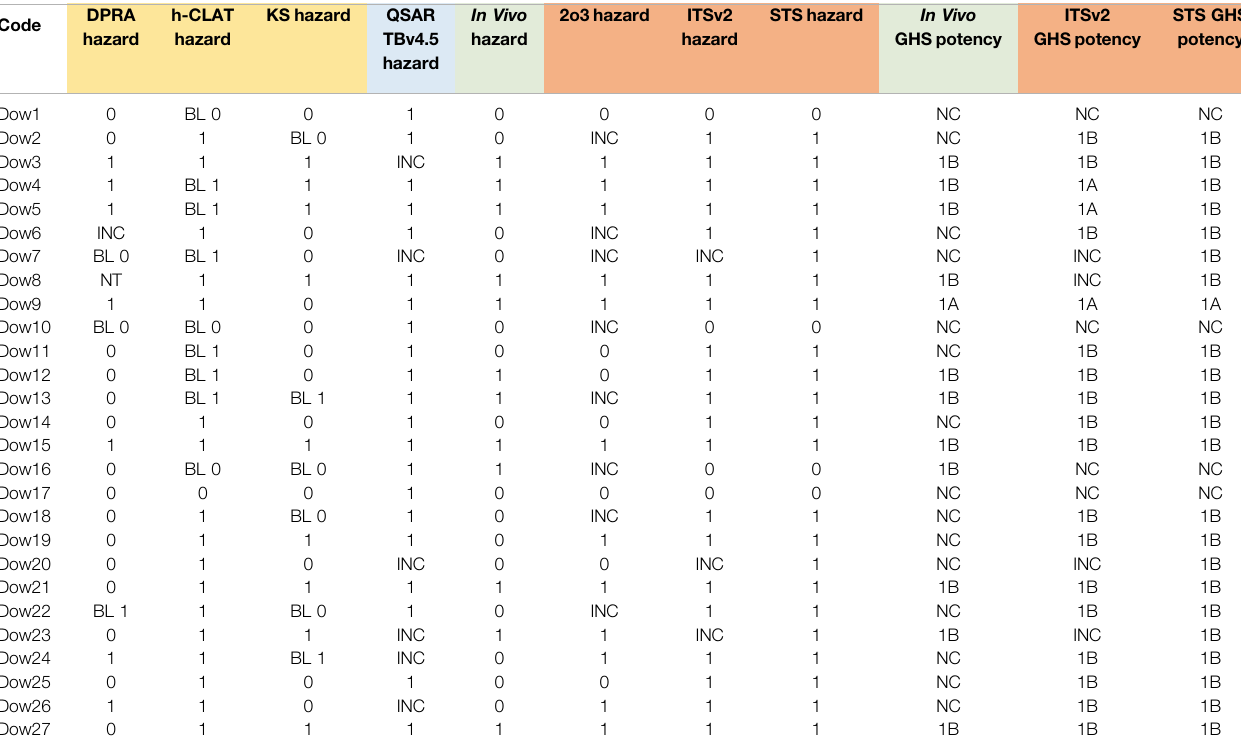
TABLE 6 | Skin sensitization results a for 27 agrochemical formulations.